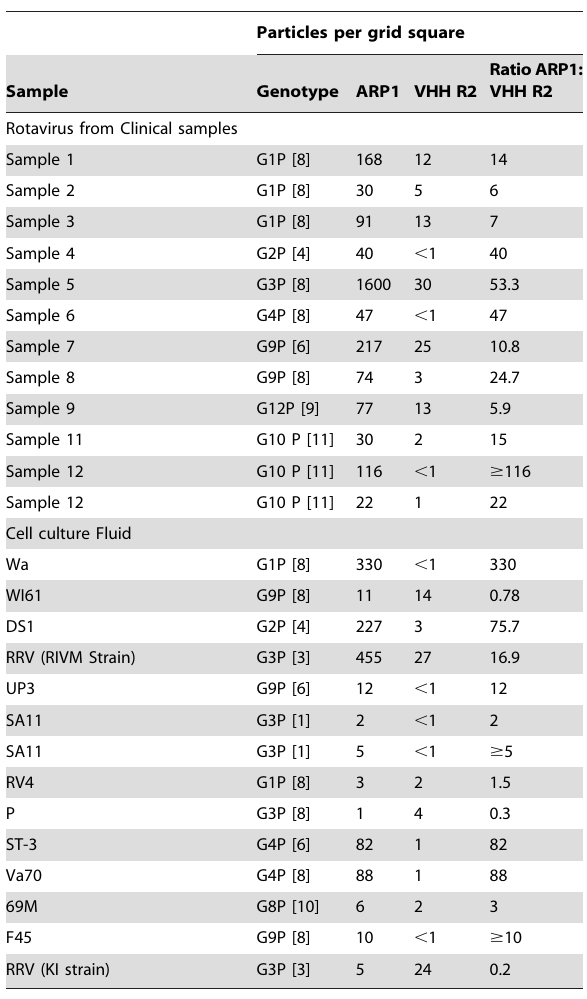
Table 2. Immune EM with rotavirus strains of different genotypes from clinical samples or cultured reference rotavirus